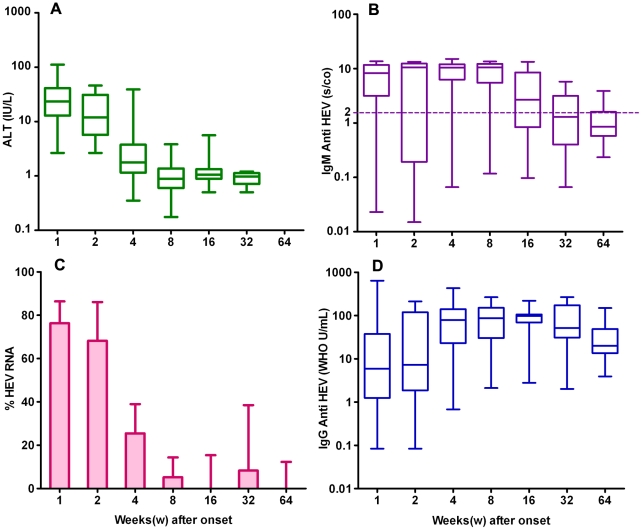
Dynamics of acute markers in acute hepatitis.Serum samples were collected from 91 consecutive hepatitis E cases within the first week of onset symptoms (n = 59) and in the subsequent intervals after onset of symptoms from: one to 2 weeks (n = 21); 2 to 4 weeks (n = 55); 4 to 8 weeks (n = 57); 8 to 16 weeks (n = 22); 16 to 32 weeks (n = 12) and 32 to 64 weeks (n = 28). The levels of ALT(A), IgM anti-HEV(B) and IgG anti-HEV(D) of the different groups of serum samples are shown as range (whiskers), interquartile (boxes) and median (line within the boxes) values. The occurrence of the viral RNA(C) was shown as % prevalence (bar) and 95% confidence interval (whiskers). Dotted line represents the cutoff levels of IgM anti-HEV (2.0 S/co).